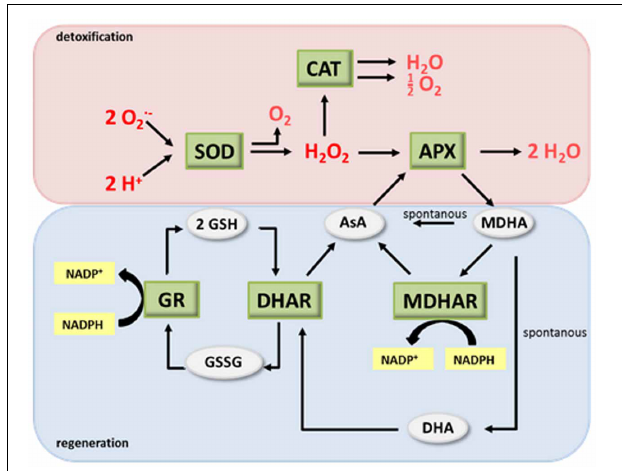
FIGURE 1 | The antioxidant system. (modified after Buchanan et al., 2002). AsA, ascorbate; DHA, dehydroascorbate; SOD, superoxide dismutase; CAT, catalase; APX, ascorbate peroxidase; MDHA, monodehydroascorbate; MDHAR, MDHA reductase; DHAR, DHA reductase; GR, glutathione reductase; GSH glutathione; GSSG, glutathione